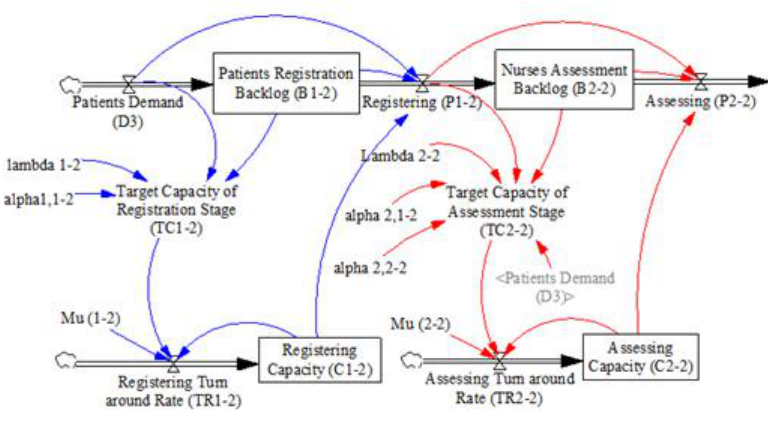
Figure 2. ER service supply chain model for the first two